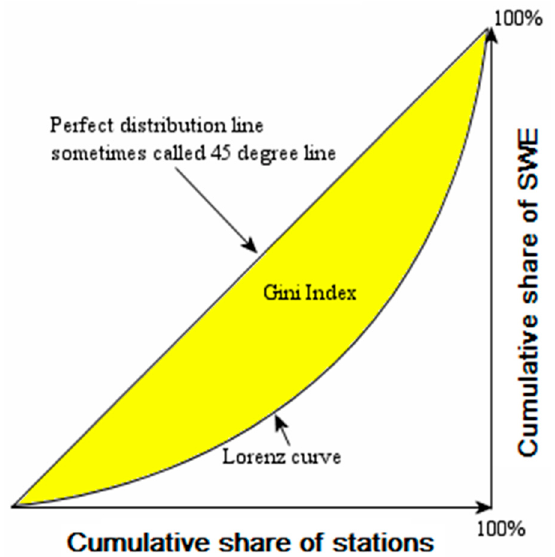
Figure 3. Graphical representation of the Gini index.